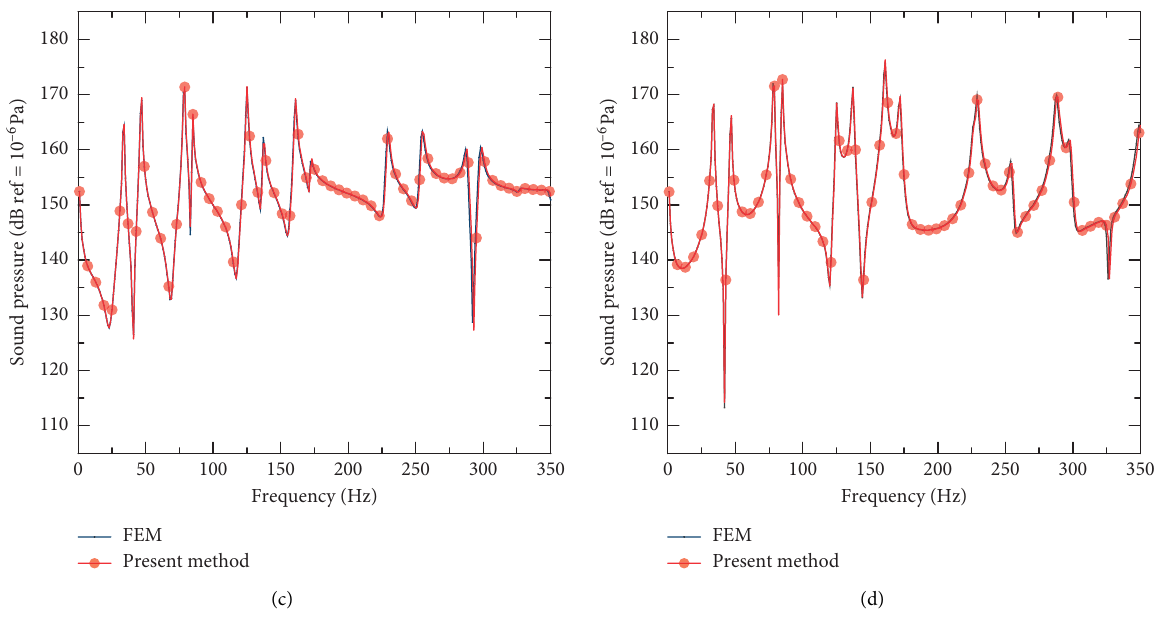
Figure 7: Response under the combined excitation of point force source and internal point acoustic source. (a) Velocity response at (0.10, 0.12, 0.14). (b) Velocity response at (0.15, 0.30, 0.14). (c) Sound pressure response at (0.08, 0.11, 0.07). (d) Sound pressure response at (0.20, 0.33,